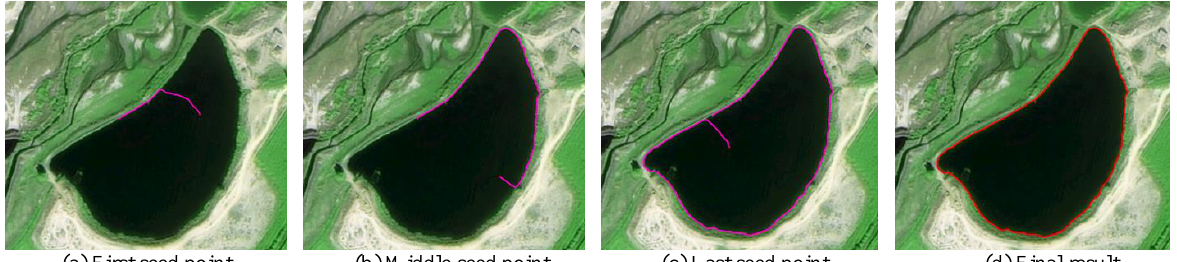
Figure 3. Water area extraction with intelligent